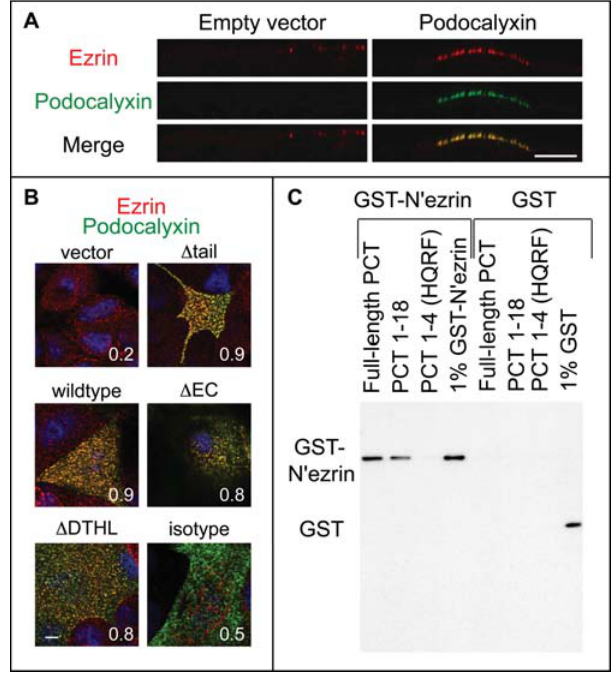
Figure 9. Podocalyxin colocalizes with ezrin in a manner indepen- dent of any direct interaction with NHERF-1. (A) Vertical slices of confocal stacks demonstrate increased apical recruitment of ezrin in Podocalyxin-transfected MCF-7 cells. Green: ectopic Podocalyxin, red: endogenous ezrin, blue: nuclei (DAPI). Scale bar: 5 m m. (B) Projections of merged apical confocal images of MCF-7 cells transfected with various Podocalyxin constructs or empty vector. Green: Podocalyxin, red: ezrin (or isotype control for ezrin), blue: DAPI. White numbers represent Pearson’s colocalization coefficient. Scale bar: 5 m m. (C) In vitro pull- down assays with biotinylated Podocalyxin cytoplasmic tail (PCT) peptides and GST-N’ezrin reveal a lack of interaction between a Podocalyxin peptide representing the cytoplasmic tail of the D tail mutant (HQRF) and ezrin. Biotinylated Podocalyxin peptides bound to streptavidin-sepharose were incubated with GST-N’ezrin or GST alone, and bound recombinant proteins were detected with an anti-GST- antibody by Western